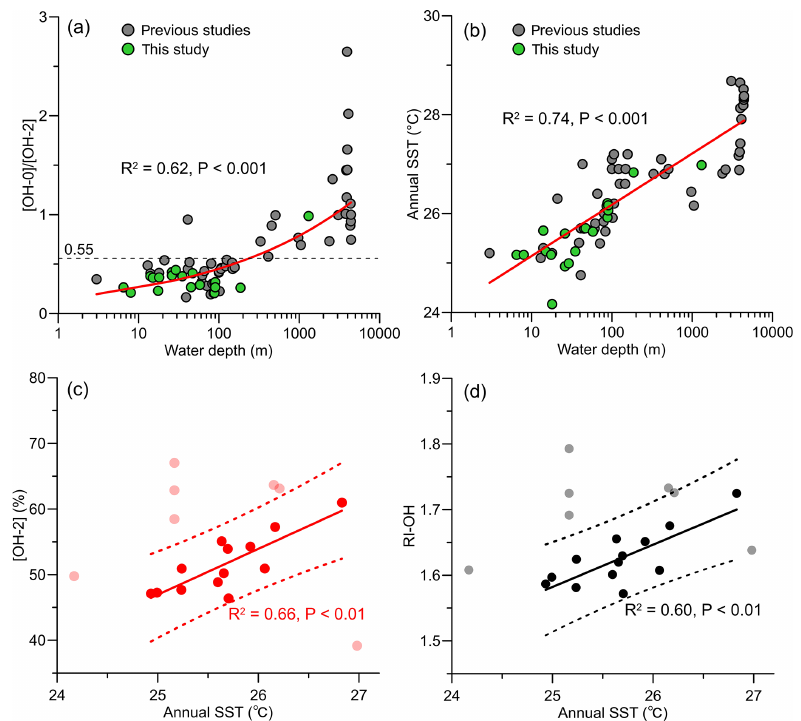
Figure 7. Changes in (a) [OH-0] / [OH-2] ratio and (b) annual SSTs with water depth, and relationship of (c) [OH-2] and (d) RI-OH with annual SSTs. Data from previous studies included in (a) and (b) are from Lü et al. (2015) and Yang et al.